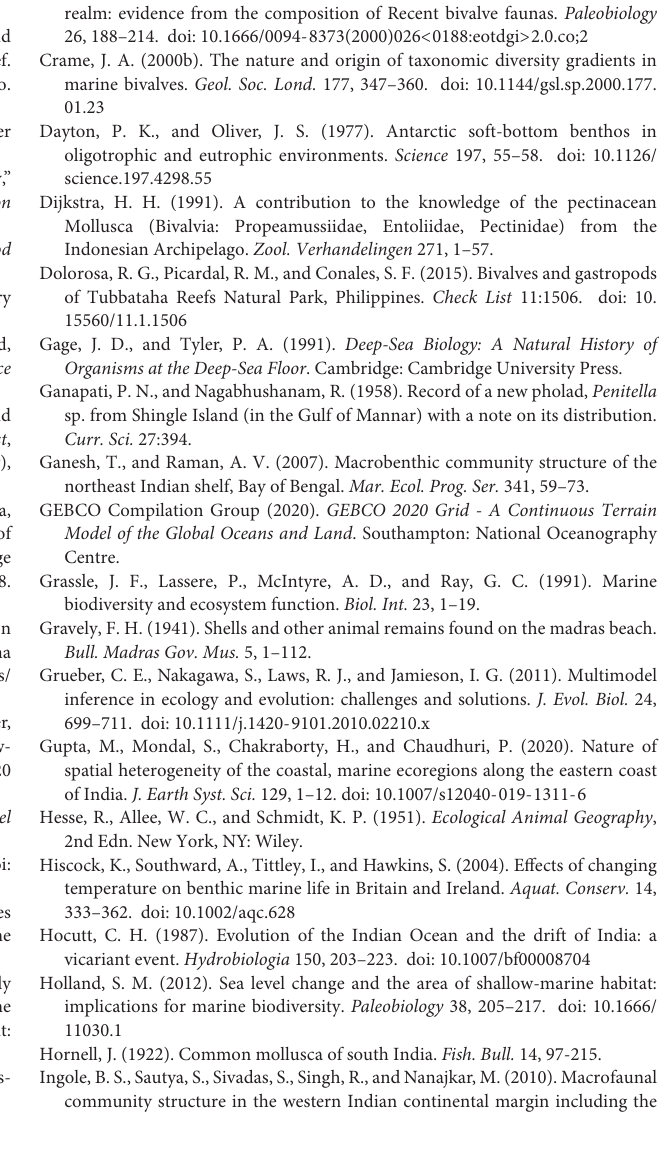
in bold. Supplementary Table 4 | Summary of the environmental variables used in the present